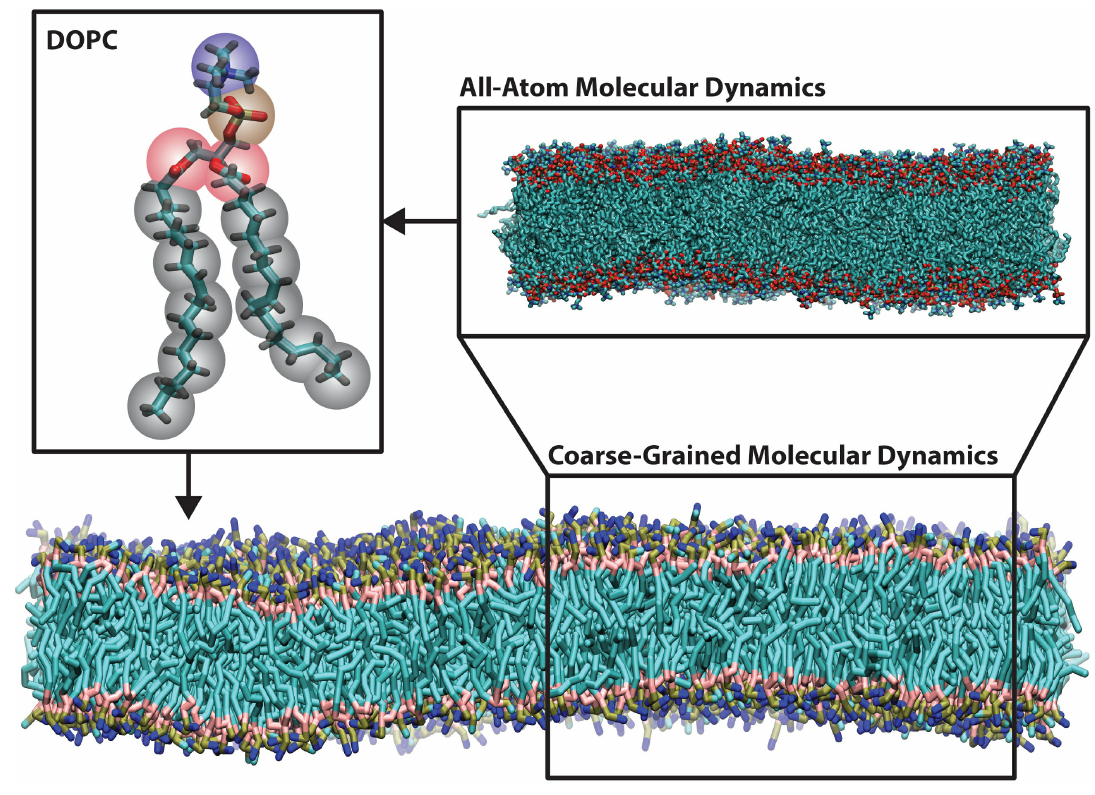
Figure 2. Representative snapshots of all-atom (upper right) and Martini coarse-grained (bottom) molecular dynamics simulations of a 4:1 dioleoylphosphatidylcholine with dioleoylphospatidylserine (DOPC/DOPS) bilayer. The upper left shows the coarse-grained mapping of a single DOPC lipid, with beads colored by bead type (gray for hydrocarbons-, pink for glycerol-, brown for phosphate- and blue for choline-type). The all-atom system contains 800 lipids, while the coarse-grained system contains 3,200 lipids (water molecules are not pictured here). Bilayers were simulated with the CHARMM36 [15] and Martini [16] force fields and rendered with Visual Molecular Dynamics